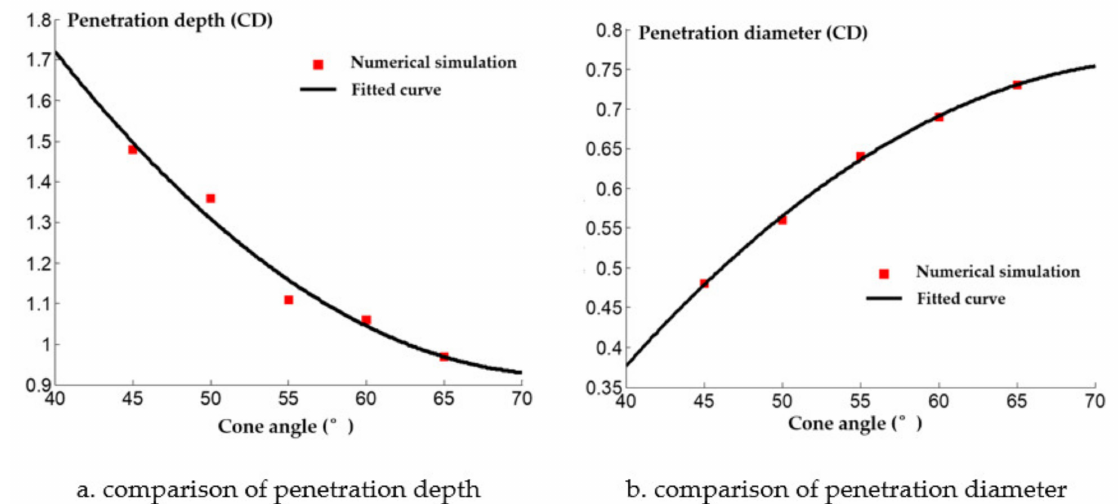
Figure 15. Penetration of reactive charge liners with different cone angles into a steel target.